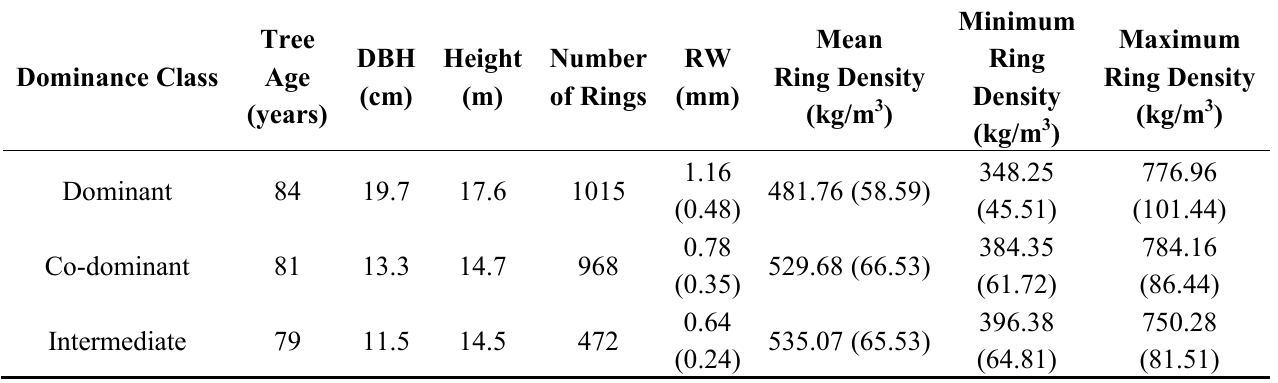
Table 2. Mean (standard deviation) ring-level characteristics for each dominance